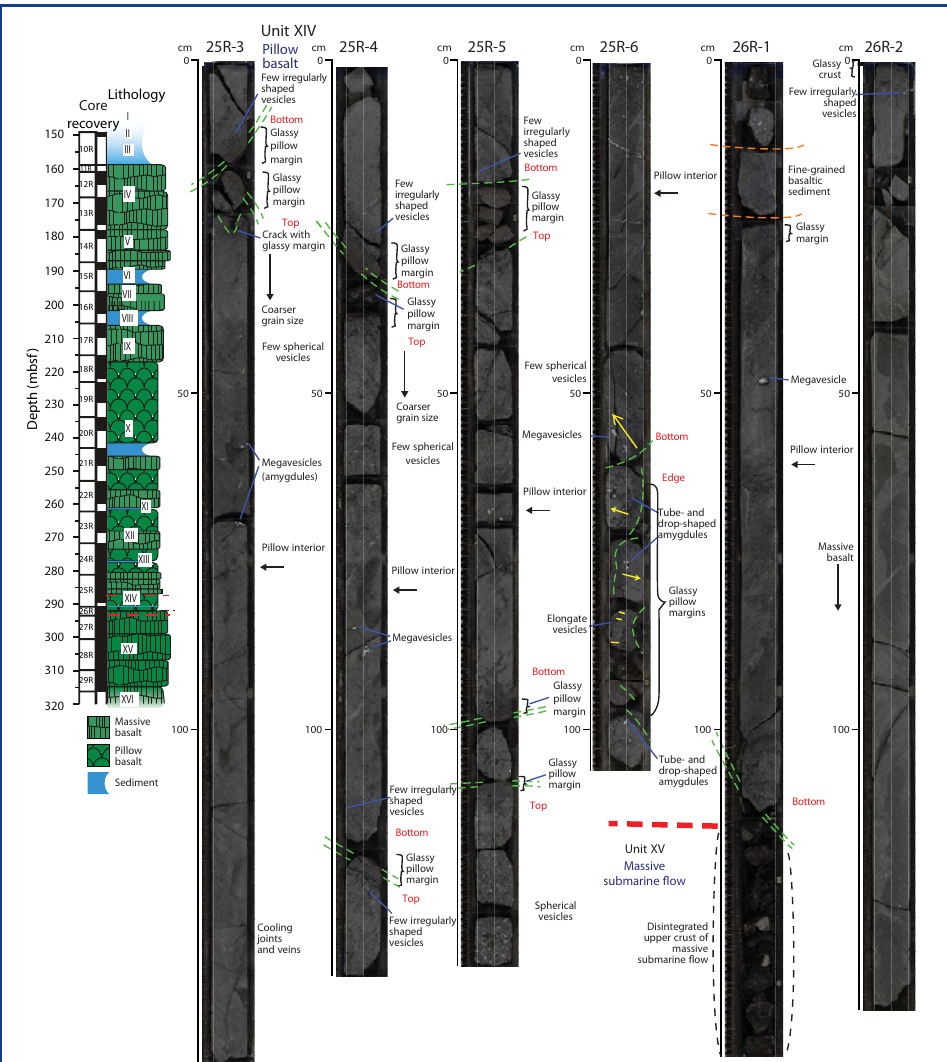
Figure 3. Core images showing pillow lavas and massive flows from Site U1347. The images are annotated with volcanological features and show a section spanning the transition between the lower pillow basalts (Unit XIV) and upper part of a massive basalt flow (Unit XV) from Sections 324-U1347A-25R-3 through 26R-2, Hole U1347A. Red dashed lines = lithologic unit boundaries, red text = top and bottom of pillow lobes, dashed green lines = glassy chilled margins. Dashed lines in lithologic column (left) show location of core sections